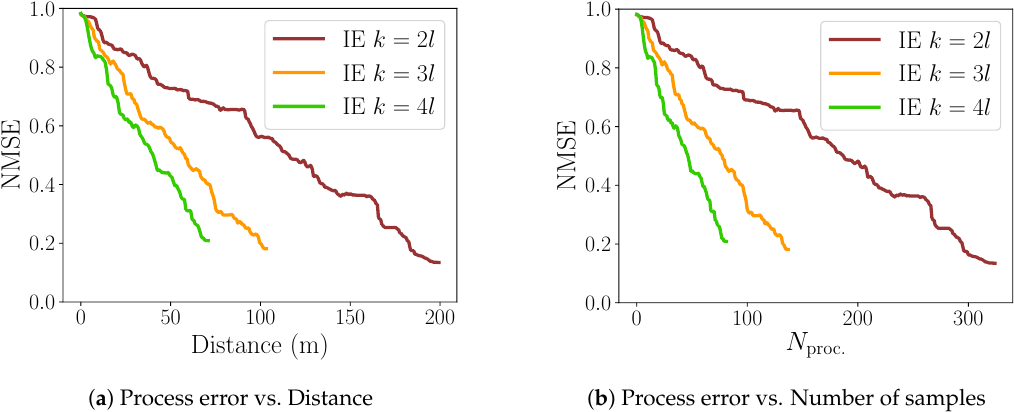
Figure 7. Variation of sampling distance parameter k